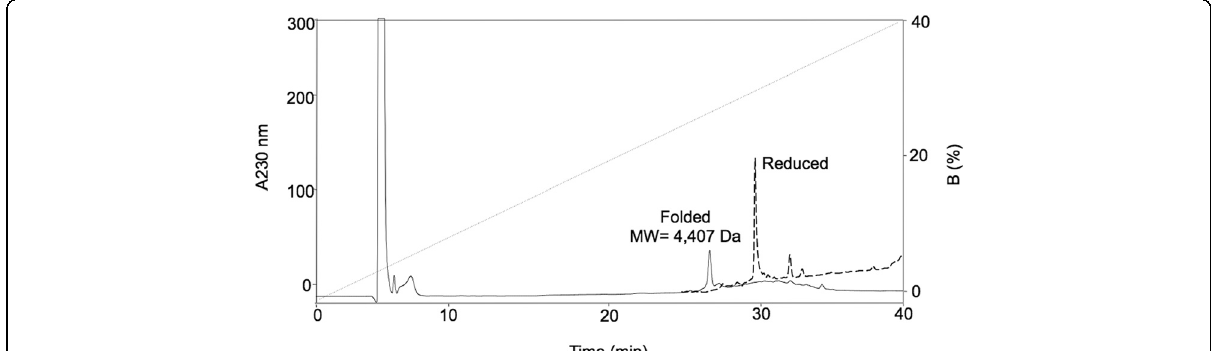
Fig. 6 Chromatographic purification of the chemically synthesized Ba1. rpHPLC profile of Ba1 before and after folding experiments. Separation was performed using a gradient from 0 to 60 % B in 60 min at 1 mL/min. The dashed line represents the reduced form of Ba1, which eluted later and it is much more hydrophobic than the folded